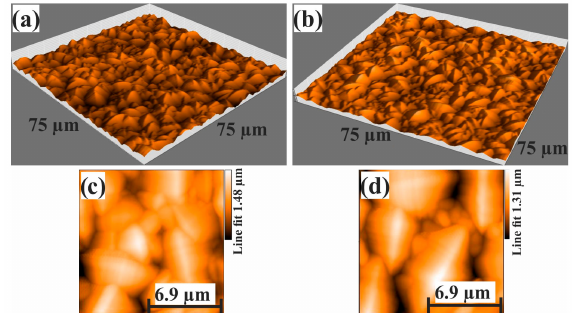
Figure 3. 3D topographies by AFM (atomic force microscopy) of Ni coatings on the Waspaloy alloy: ( a , c ) Ni-Sol-Wasp, and ( b , d ) Ni-Age-Wasp.